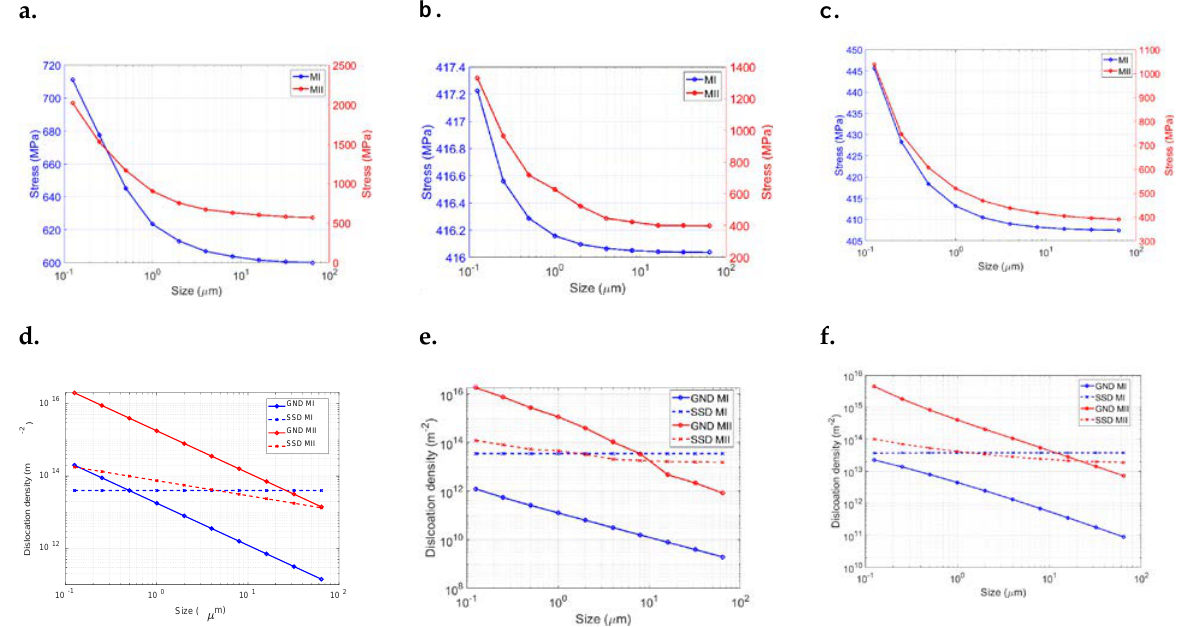
Figure 10. A comparison between the results of the CPFE model, using Method I and II, for the single crystal model in Figure 2a at ten different grain sizes. Stress along the loading direction for the misorientation angles of ( a ) 22.5°, ( b ) 45°, and ( c ) 67.5°. GND and SSD densities for the misorientation angles of ( d ) 22.5°, ( e ) 45°, and ( f ) 67.5°. The values on the x-axis represent the size of the single crystal. Hall-Petch effects are switched off.